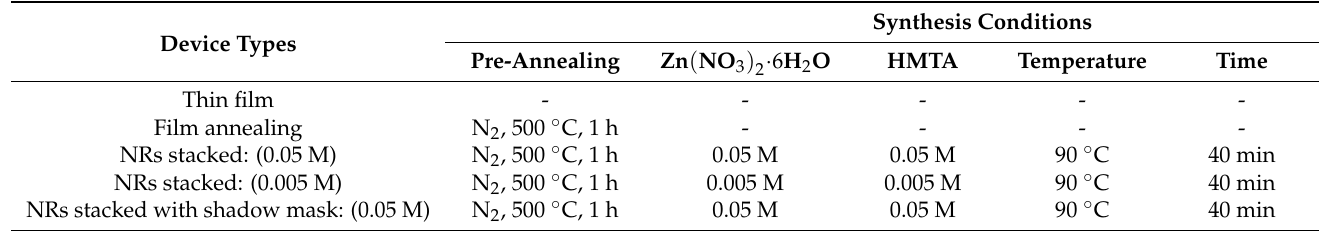
Table 2. Hydrothermal synthesis